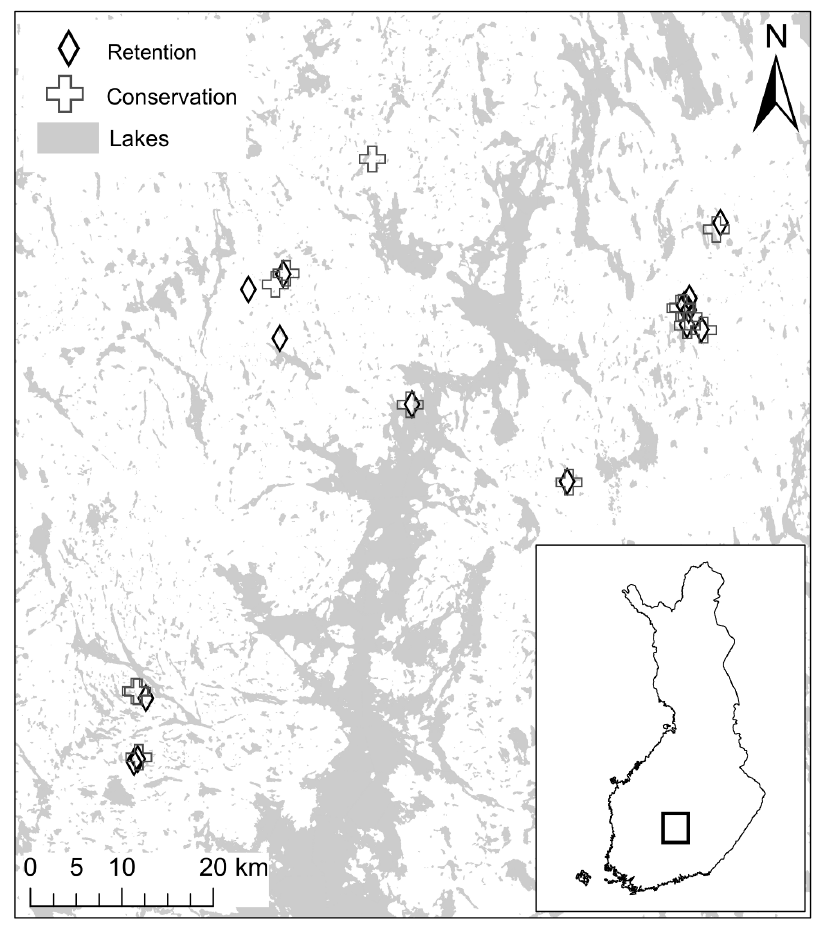
Figure 1. Map of study sites in Central Finland. (cid:2) National land survey of Finland 2013.